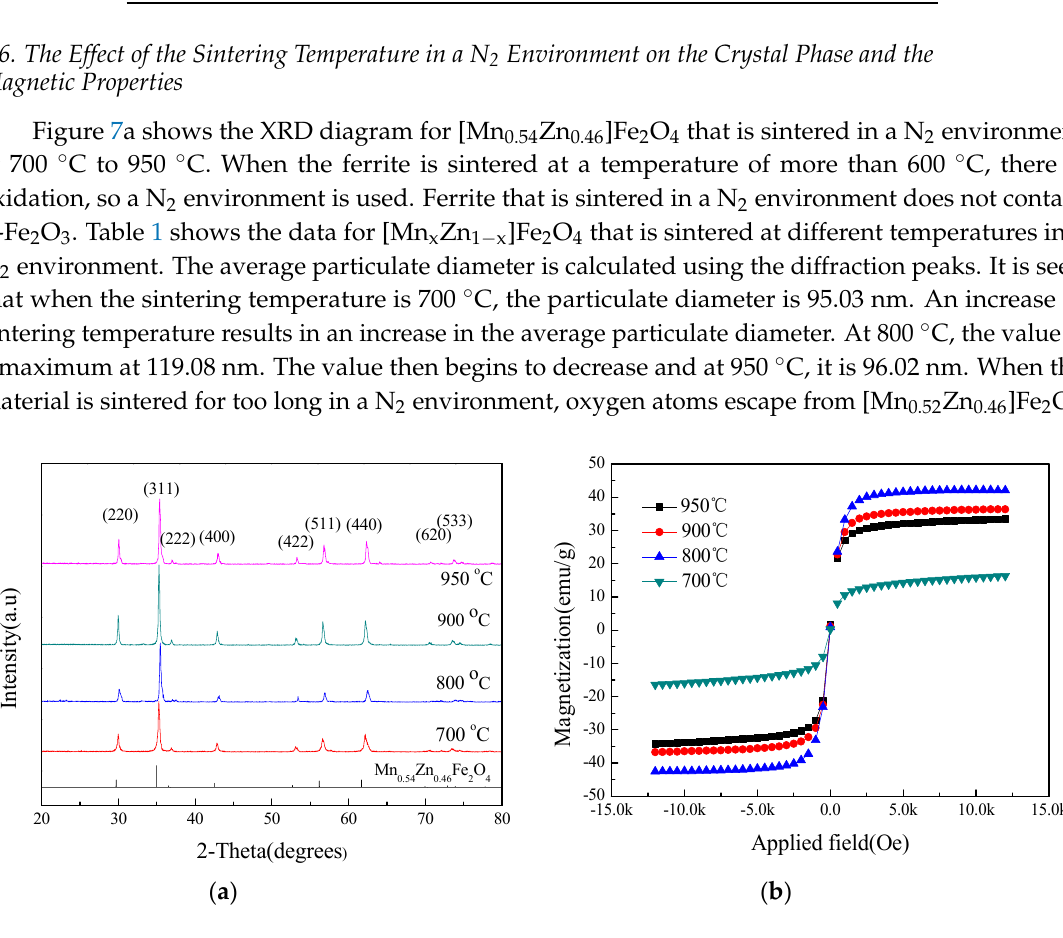
Figure 7. The effect of sintering temperature in a N 2 environment on ( a ) the crystal phase and ( b ) the magnetic properties of Mn 0.54 Zn 0.46 Fe 2 O 4.